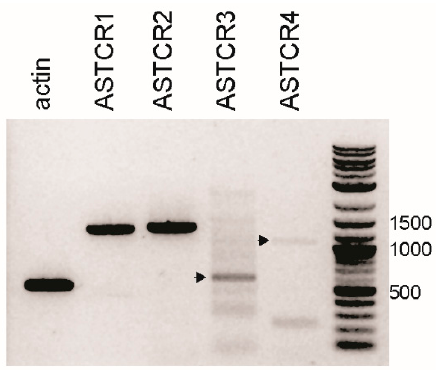
Figure 2. Transcripts encoding ASTCRs are expressed in the CG. RT-PCR amplification of full- length open reading frames encoding the four respective H. americanus ASTCRs from pooled CG cDNAs. Expected amplimer sizes: ASTCR1—1263-bp; ASTCR2—1305-bp; ASTCR3—753-bp (ar- rowhead); and ASTCR4—1032-bp